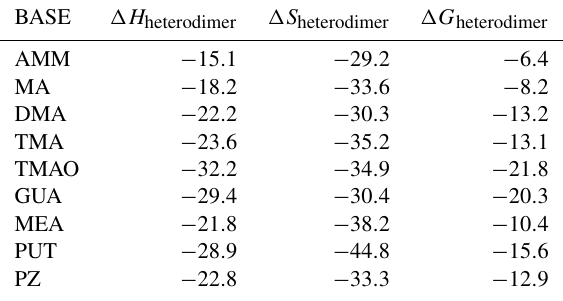
Table 3. Calculated enthalpy ( (cid:49)H heterodimer in kcalmol − 1 ), en- tropy ( (cid:49)S heterodimer in cal(molK) − 1 ) and Gibbs free energy ( (cid:49)G heterodimer in kcalmol − 1 ) for SA–base heterodimer formation at